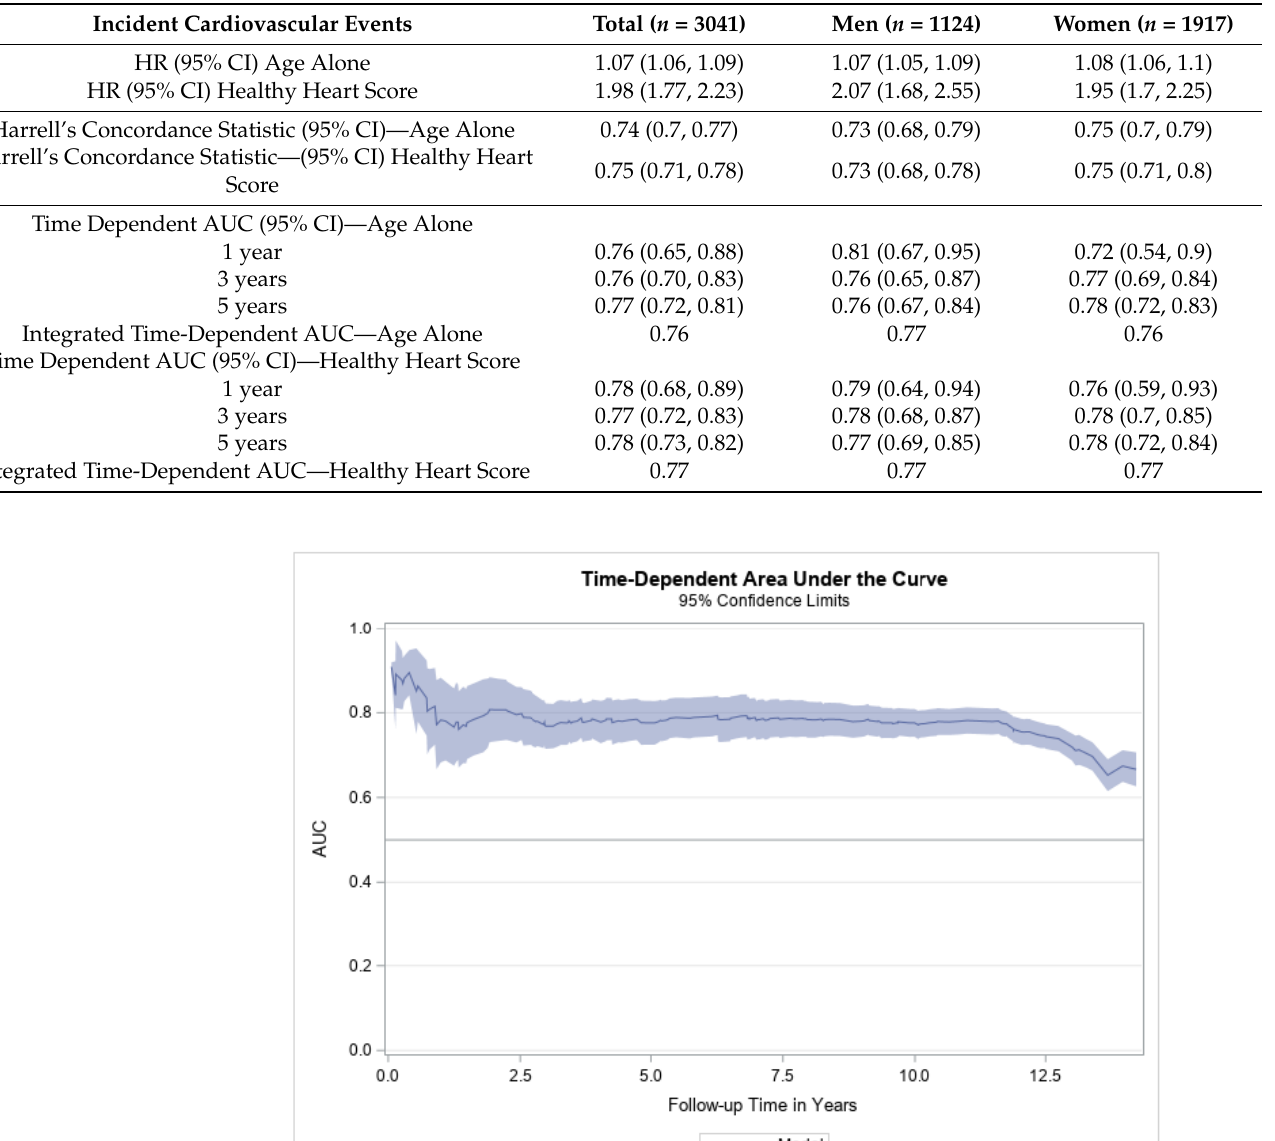
Table 2. Model performance of the Healthy Heart Score in the JHS for Cardiovascular Events in the overall cohort, men and women.